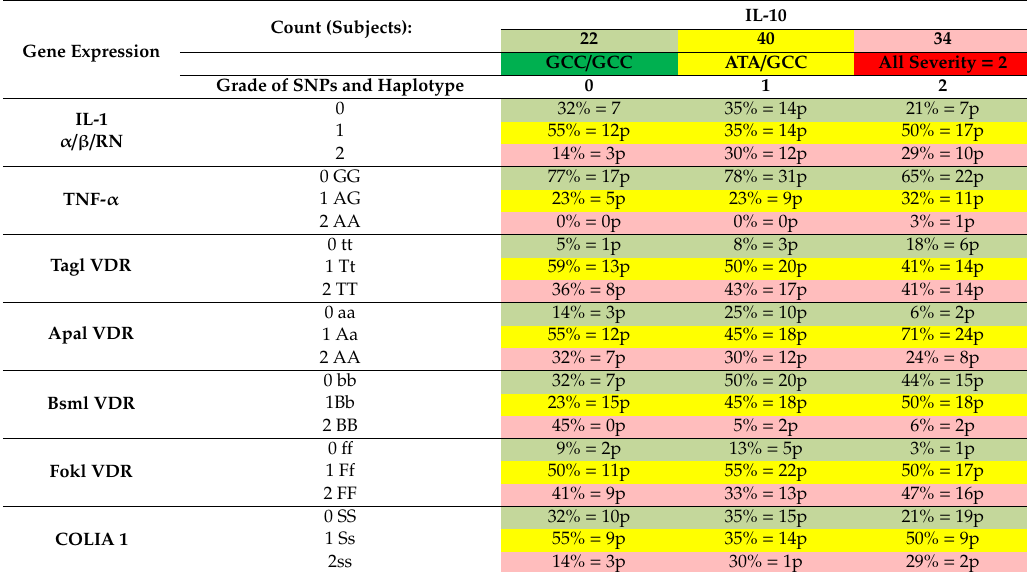
Table 5. IL-10 polymorphism in the three groups in correlation with other gene expression. IL-10 severe SNPs (ATA / ATA-ATA / ACC-ACC / ACC) included VDRs SNPs, especially seen in Taql, Apal, and Fokl ( p < 0.05) (red and yellow with Taql TT / Tt, Apal AA / Aa, Foql FF / Ff); IL-10 moderate SNPs (ACC / GCC) included VDRs SNPs seen in VDR Taql, 17 patients TT (red) ( p < 0.05) and 20 patients Tt (yellow). The SNPs in IL-10 functionally expressed by ATA / ATA-ATA / ACC-ACC / ACC genotypes have no statistically significant relation with COLIA1 gene expression. IL-10 depletion had very low e ff ect on COLIA1 gene expression, genotypes analysis revealed 2 ss (red color), 9 Ss (yellow color), and 19 SS (green color); SNPs in IL-10 functionally expressed by ATA / ATA-ATA / ACC-ACC / ACC genotypes showed a certain degree of correlation with ILs-1 group. Patients with IL-10 depletion showed a substantial a ff ection IL-1gene expression, genotypes analysis showed 10 severe (red color), 17 moderate (yellow color), and seven without alteration (green color). IL-10 polymorphisms (ATA / ATA-ATA / ACC-ACC / ACC) and TNF- α showed a moderate inverted type of correlation. SNPs at IL-10 showed a quite substantial e ff ect on patient’s TNF- α gene expression. Severe IL-10 depletion showed no e ff ect on TNF- α gene activity that was statistically significant ( p > 0.05). From severe to moderate to normal IL-10 gene expression TNF- α was shown to be always substantially regularly expressed from 65% to 78% to 77% in the GG haplotype, 32%, 23%, and 23% in the AG haplotype and practically 0–3% in AA haplotype (red = severity grade 2; yellow = severity grade 1; green = severity grade 0, normal